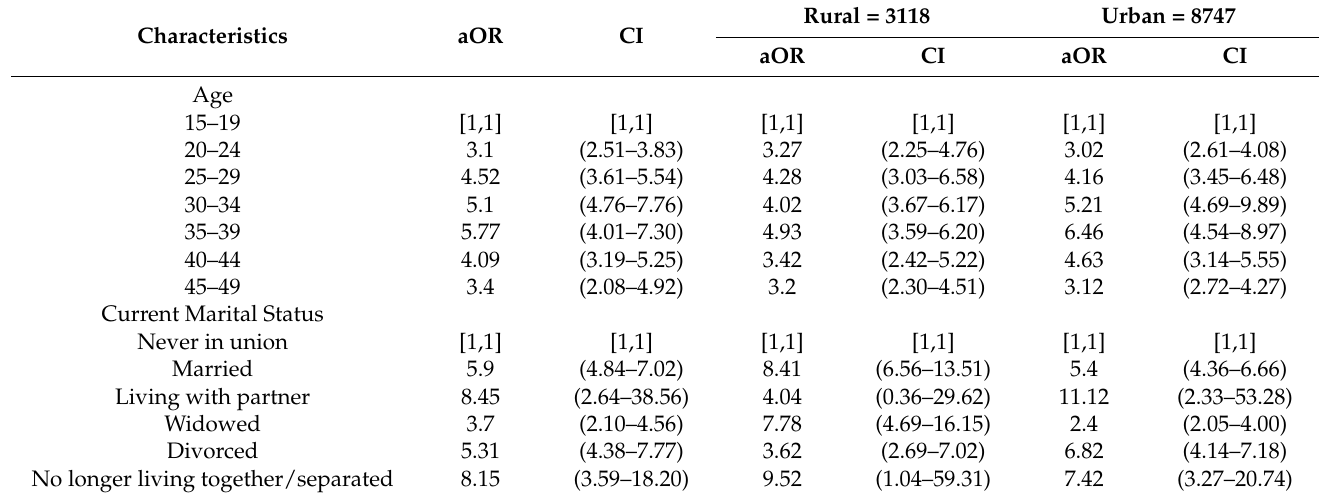
Table 3. Logistic regression analysis of the factors associated with HIV Testing among reproductive women aged 15–49 years in the Gambia, (N =